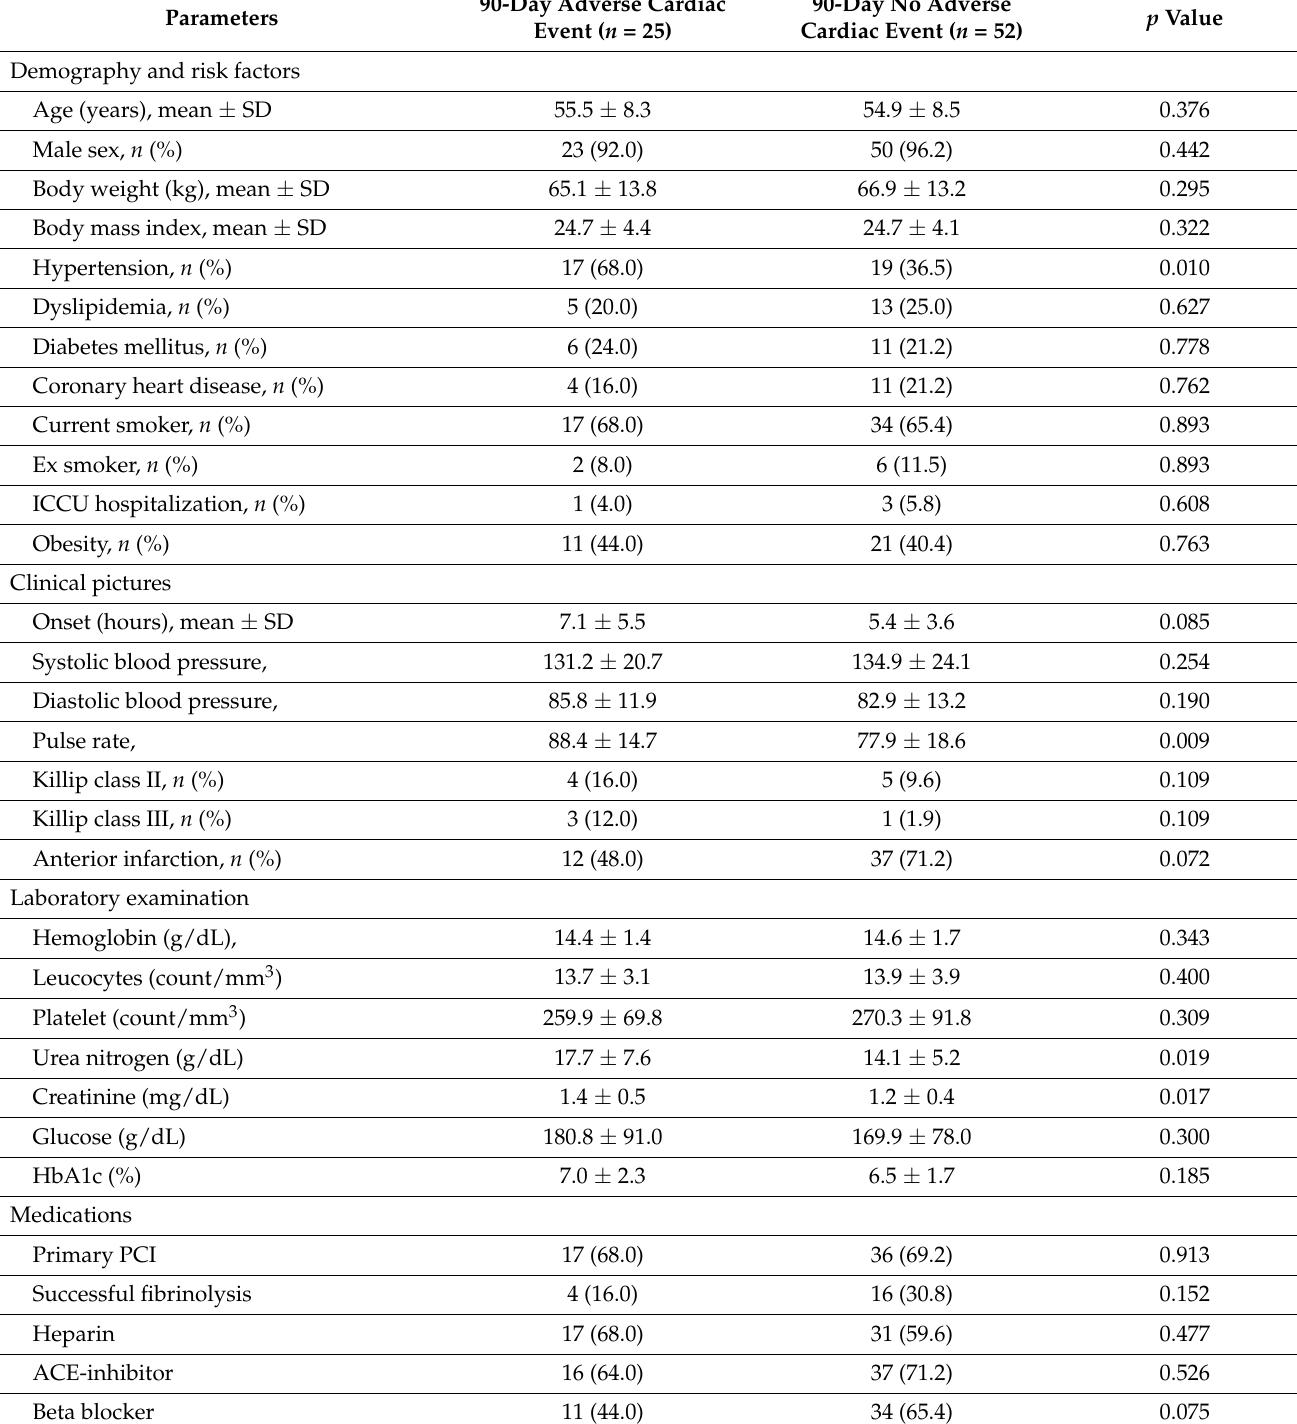
Table 5. The characteristics of subjects divided by the presence and the absence of 90-day follow up adverse cardiac